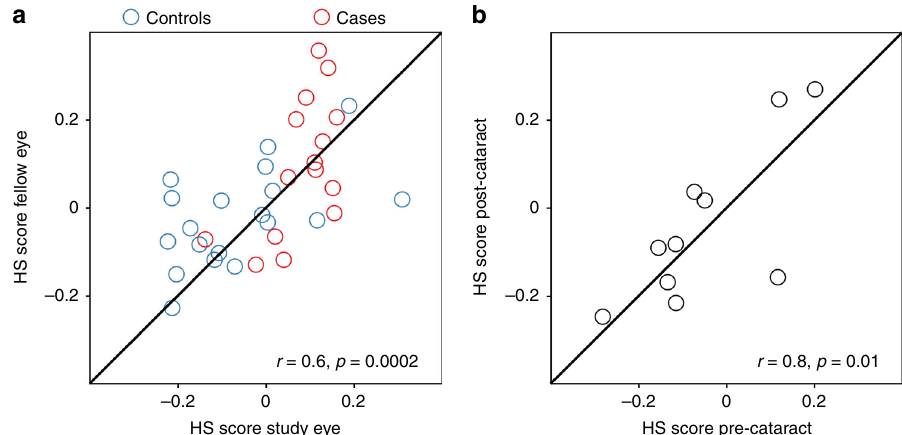
Fig. 6 Hyperspectral (HS) scores show robust agreement between eyes and before and after cataract surgery. a Correlation showing good agreement between the HS scores of the study and fellow eye ( n = 15 cases, red; n = 19 controls, blue). b Correlation showing good agreement between the HS scores pre- and post-cataract surgery ( n = 10 independent participants). Source data are available as a Source Data fi le